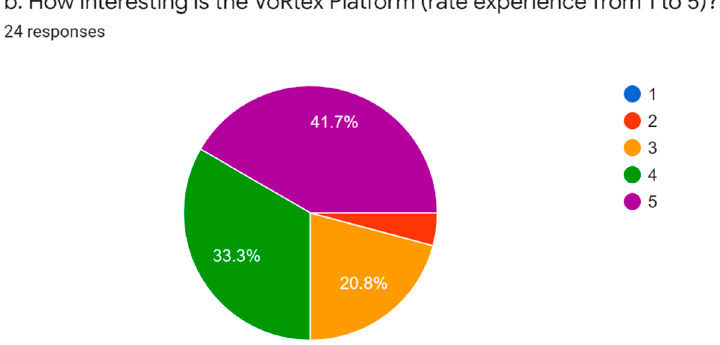
Figure 13. VoRtex test results from Google Forms report. Overall user experience based on the case study.